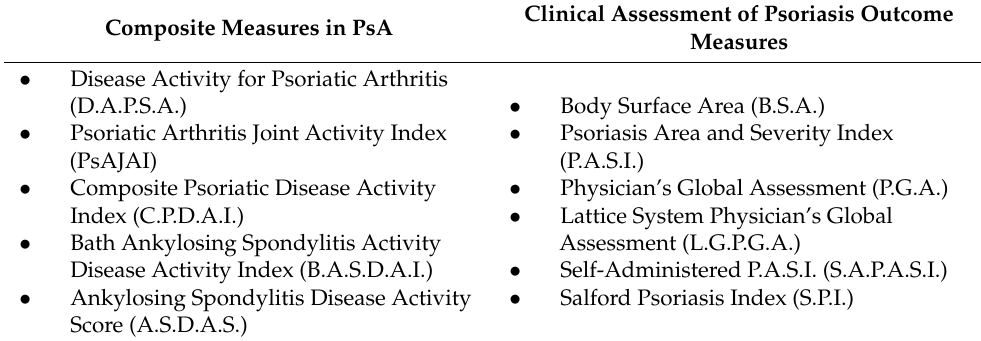
Table 3. Composite measures in PsA and clinical assessment of psoriasis outcome measures